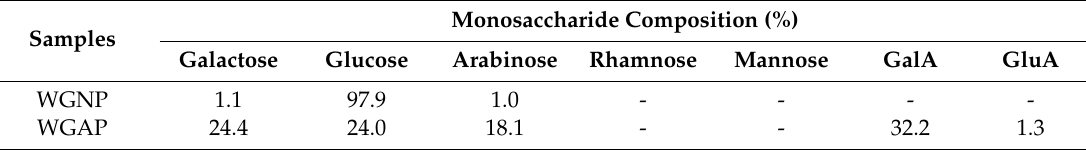
Table 2. Chemical composition of WGNP and WGAP.